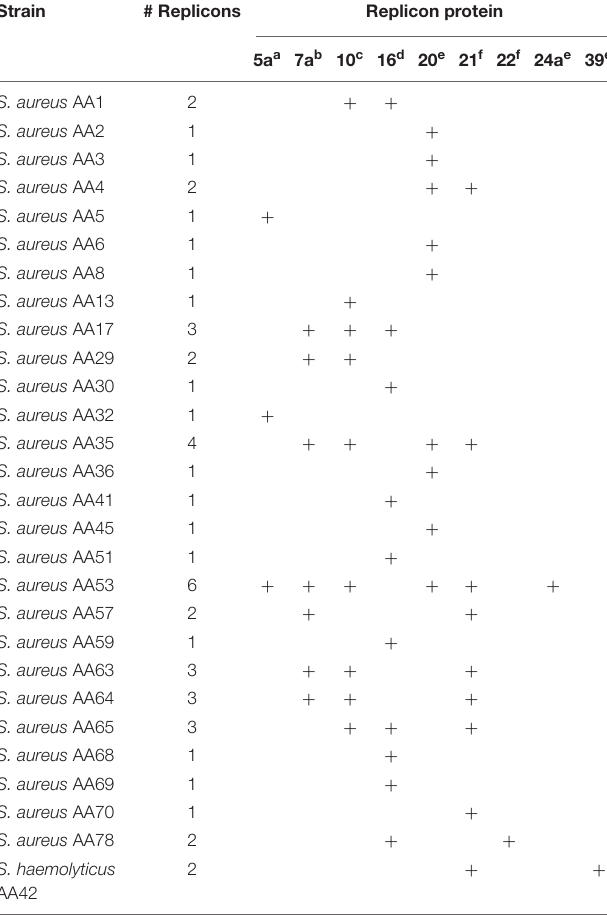
TABLE 2 | Number and type of replicons identified by PlasmidFinder for plasmid sequences in the Egyptian S. aureus strains and S. haemolyticus strain. Strain # Replicons Replicon protein